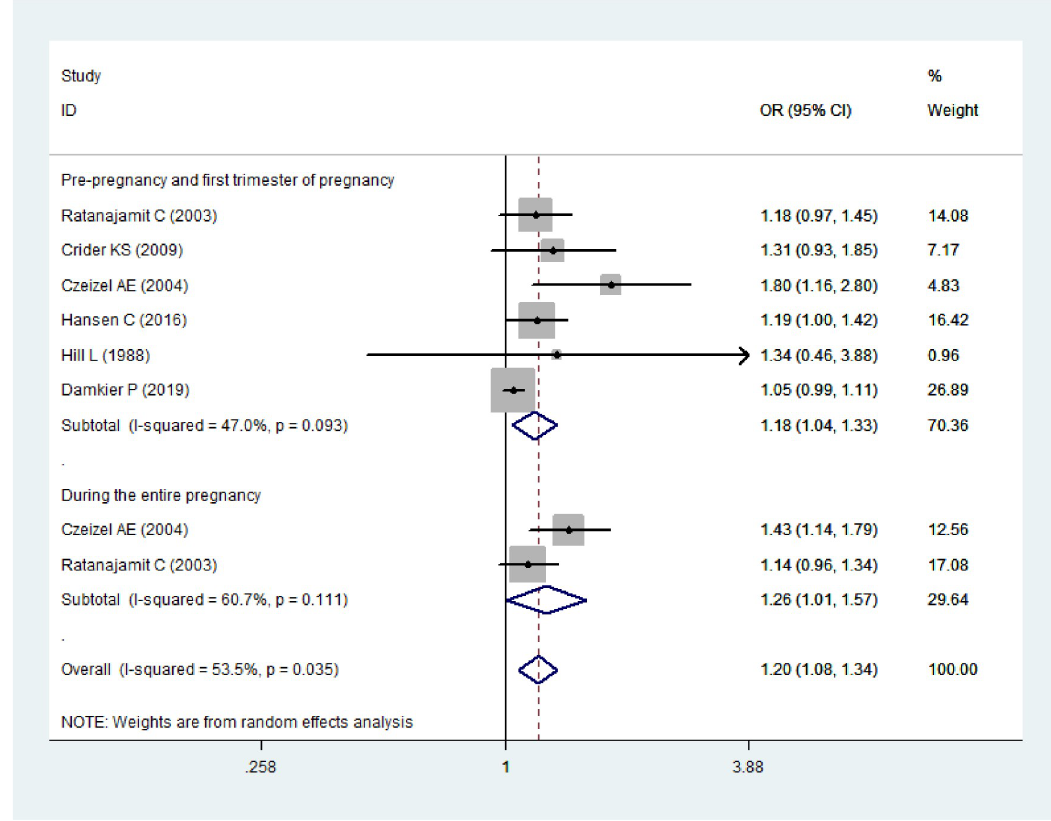
Fig 3. Forest plot with pooled odds ratios of the effect of maternal exposure to sulfonamides on offspring’s congenital malformations-subgroup analysis by periods of gestation.